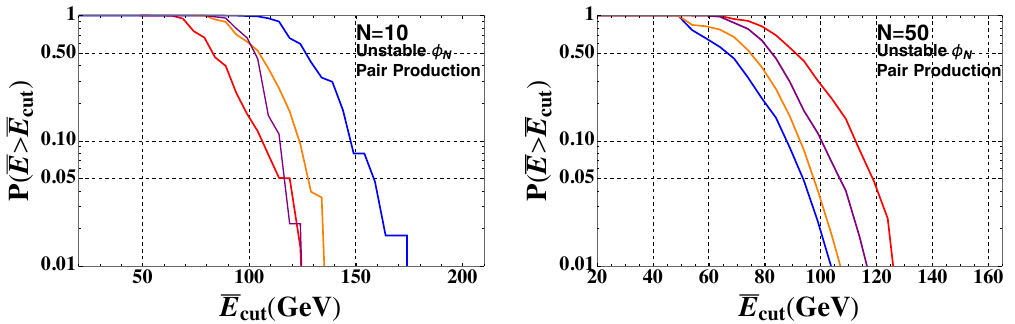
Figure 16. Fraction of events with average energy per particle above E the scenario where all couplings in eqs. (3.1) and (3.2) are present and pair production dominates. Left: 10 scalars, right: 50 scalars.